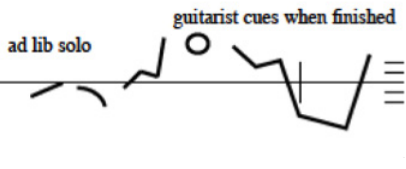
Figure 15. An example of graphic notation for a live electronic musician.